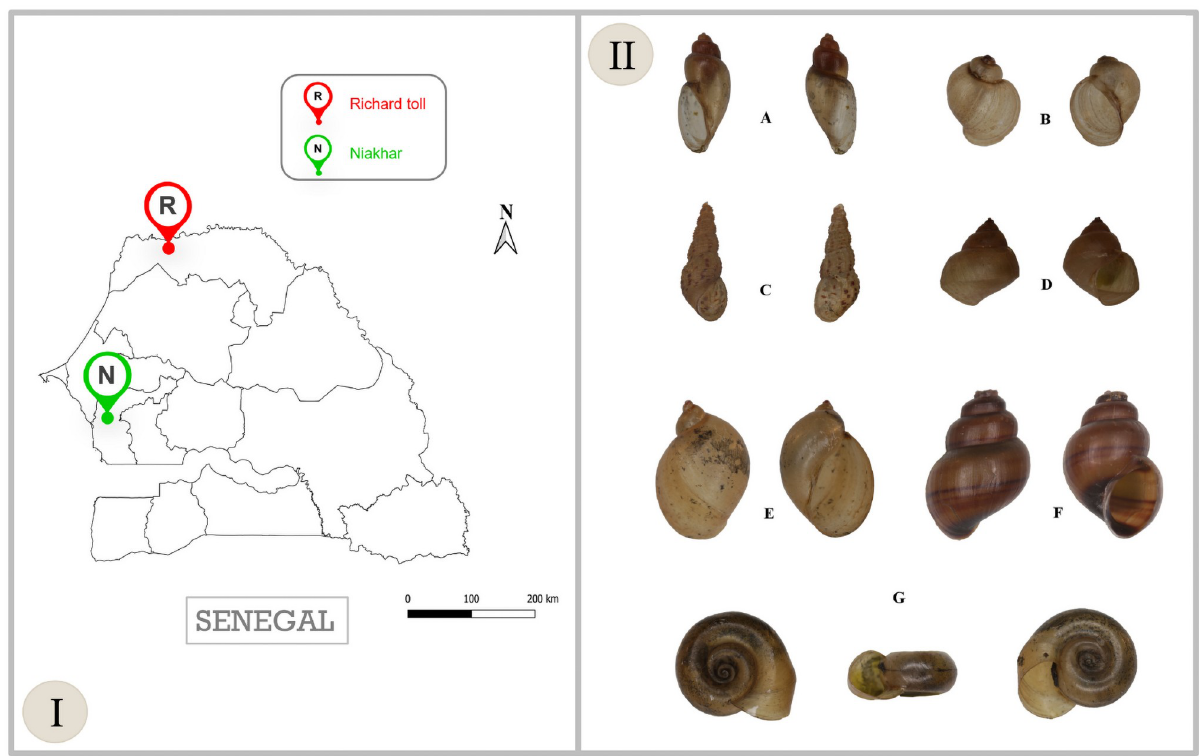
Fig 1. Map of Senegal showing the snail collection sites and the list of freshwater snails collected from two sites in Senegal. (I) The map of Senegal showing the sites from which the sample collections were conducted. “R” refers to species collected in Richard Toll; Biomphalaria pfeifferi (239), Bulinus truncatus (127), Lymnaea natalensis (38), Melanoides tuberculata (37), Bellamya unicolor (20), Cleopatra bulimoides (1). “N” refers to Bulinus senegalensis (68) collected in Niakhar and morphologically identified. (II) shows the shells of freshwater snails confirmed molecularly: Bu . forskalii (A), Bu . truncatus (B), M . tuberculata (C), Be . unicolor (D), L . natalensis (E), C . bulimoides (F) and Bi . pfeifferi (G). The map used in this study are not subject to copyright. Map of Senegal: QGIS.org, 2021. QGIS Geographic Information System. QGIS Association.